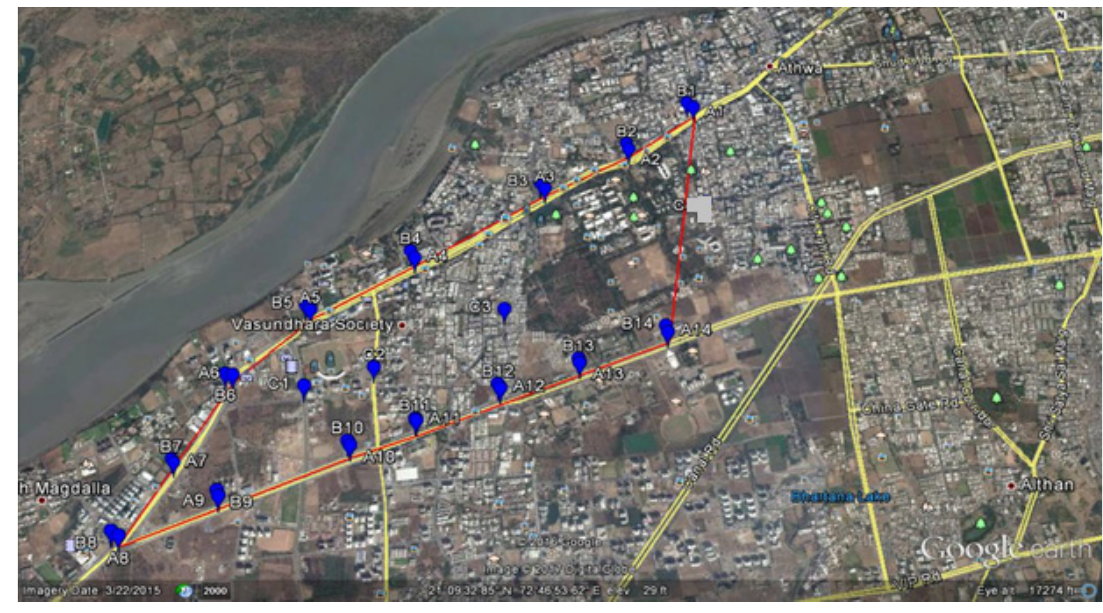
Figure 2: Map of South-West zone of Surat city with monitoring locations